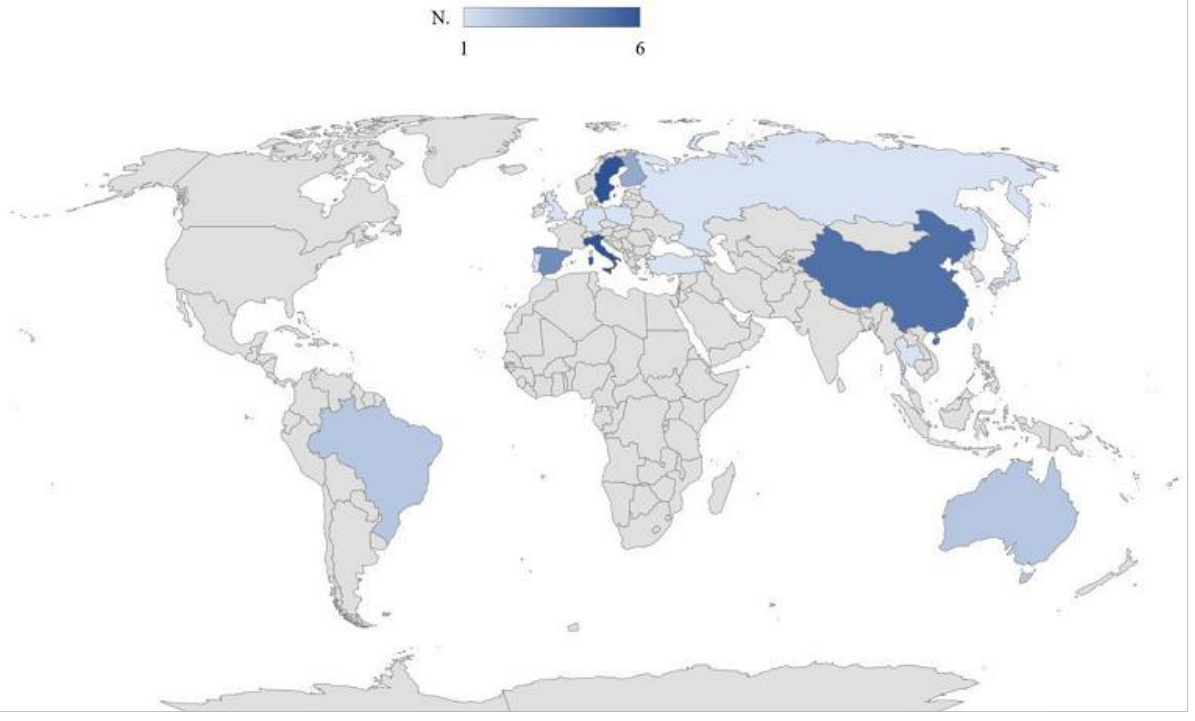
Figure 4. Geographical areas according to corresponding authors’ affiliations. Source: personal elaboration by the authors. Table 2. Investigated subject and subtopics. Notes: PS = physical sciences; SS = social sciences; Source: personal elaboration by the authors.